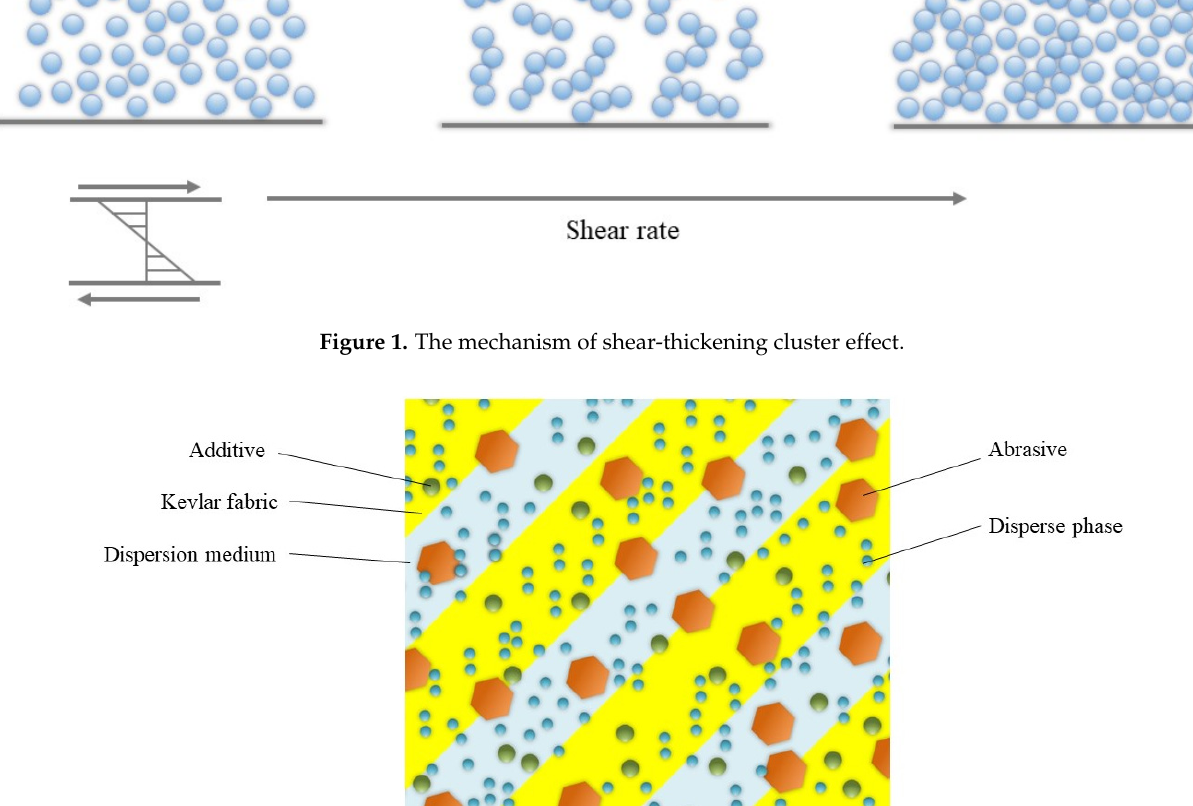
Figure 2. Composition of the high-shear low-pressure grinding wheel.